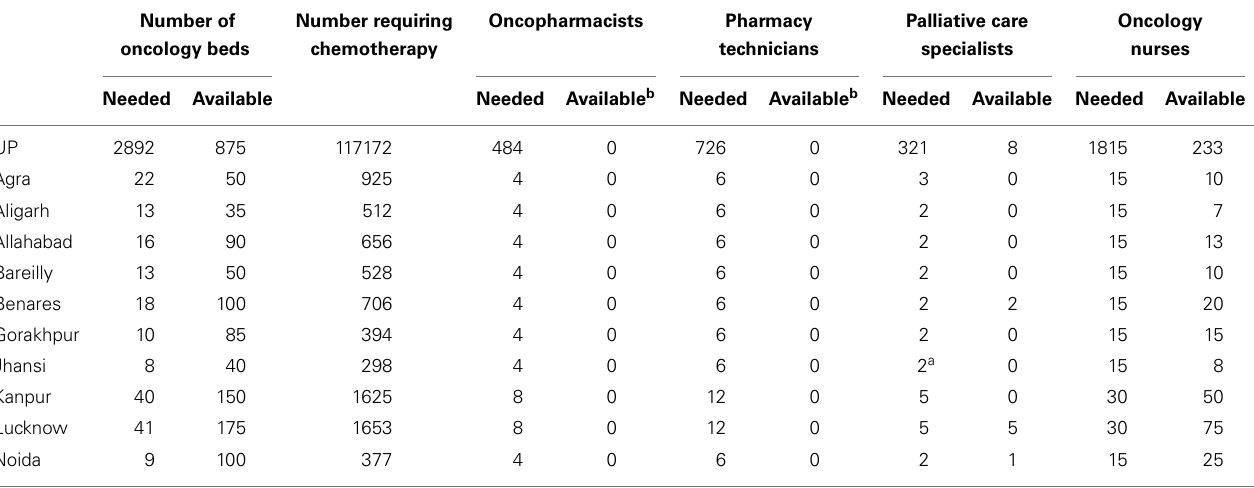
Table 4 | Number of oncology beds, nurses, pharmacy staff, and palliative care specialists needed versus those available for UP and its 10 cities with radiation therapy centers based upon GLOBOCAN 2008 data .